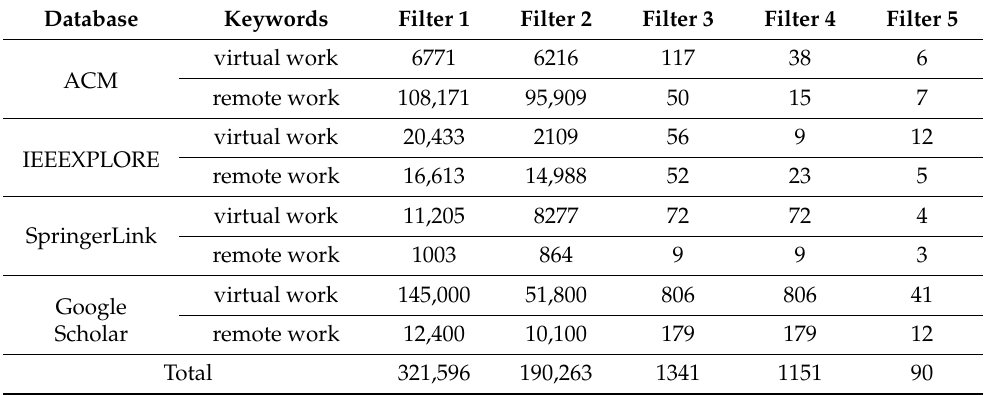
Table 2. Filtration process applied during the systematic literature review (SLR) methodology.